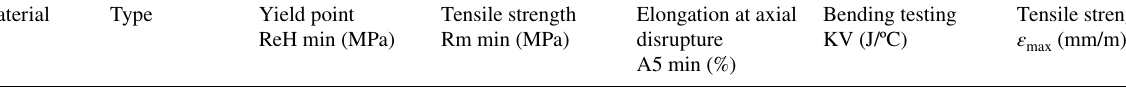
Table 1 List of strength parameters for particular types of steel No. of